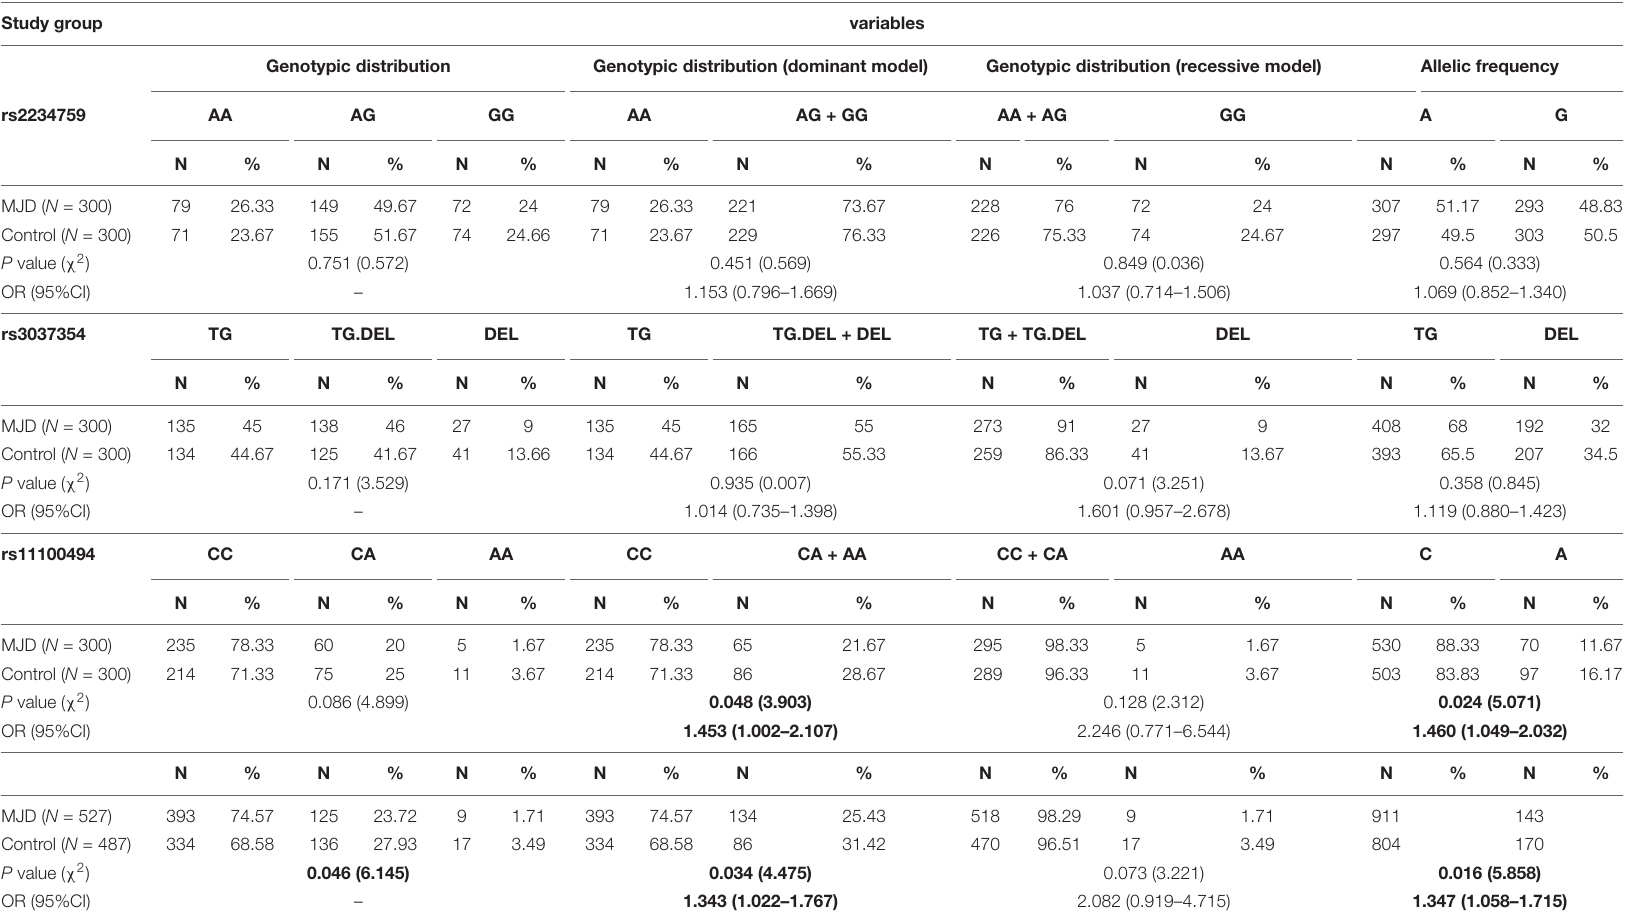
TABLE 2 | Correlation analysis between genotypes and alleles of selected SNPs and susceptibility of MJD. Study